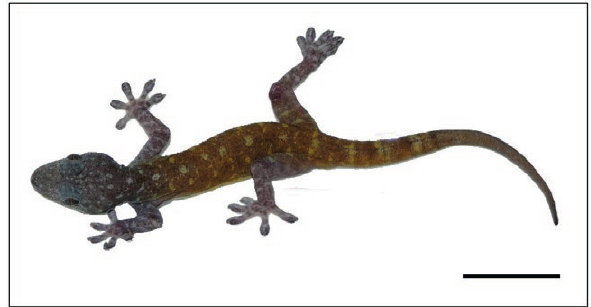
Figure 1. General characteristic of G. petricolus (scale bar = 5